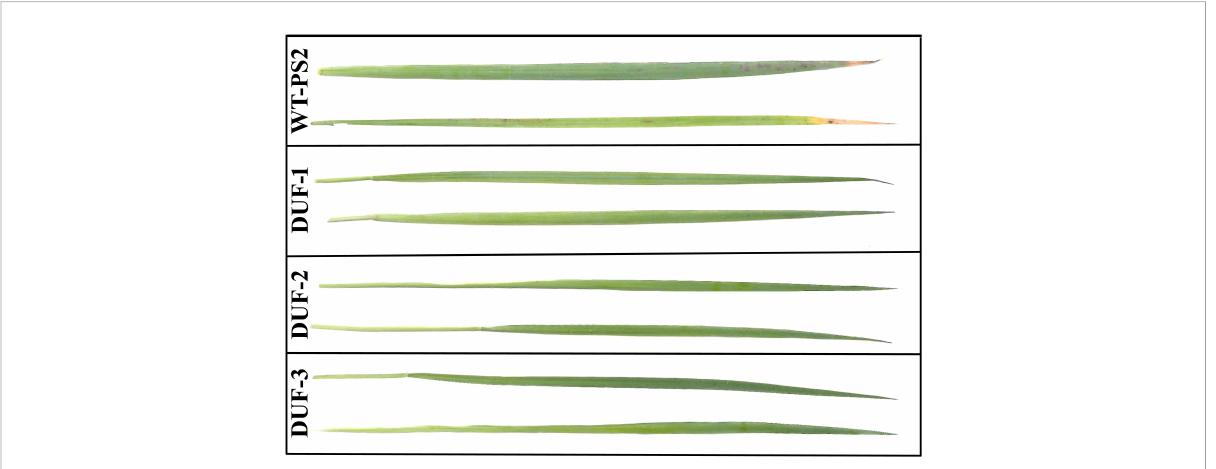
FIGURE 8 AtRD29A::OsSRDP transgenic PS2 rice plants exhibited resistance to rice blast fungus M. oryzae . Rice blast disease symptoms of WT (PS2) and AtRd29A::OsSRDP transgenic lines (DUF-1, DUF-2, and DUF-3) infected with the M. oryzae strain (Mn-ni-25) after 72 hpi. Conidial suspensions (1×10 5 conidia/ml in 0.02% Tween-20) were sprayed onto the leaf surfaces of 21-day-old rice